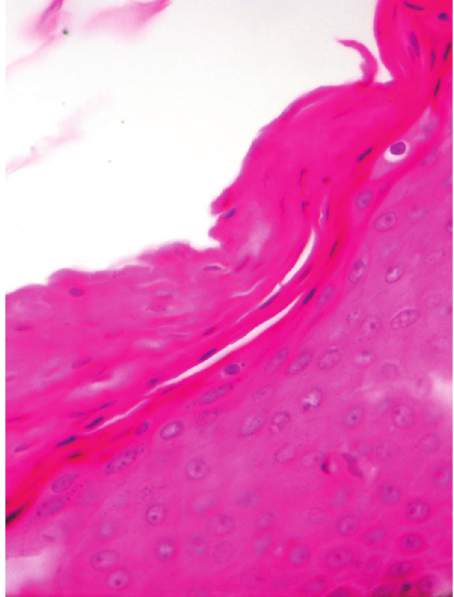
Figure 3 - Histological section under high power showing parakeratosis and slight dyskariosis (H&E, 100 6 ).